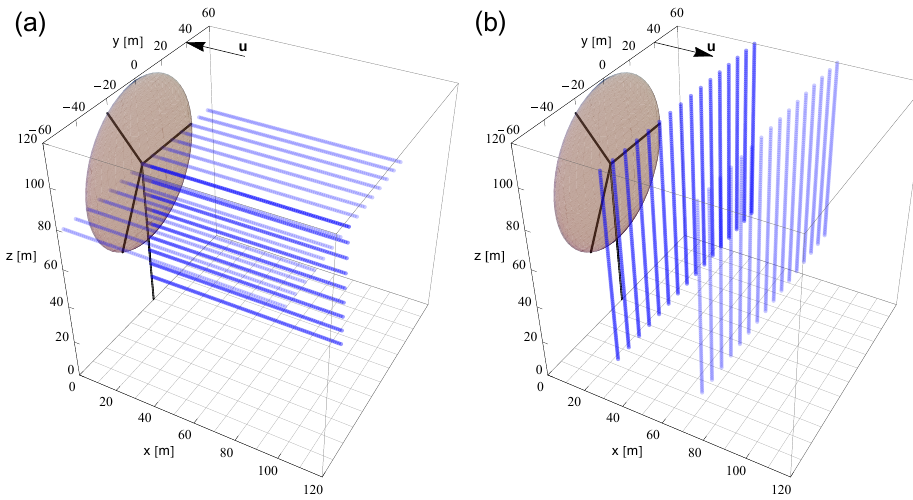
Figure 9. Scanning patterns of short-range WindScanners: (a) T-scan; (b) vertical planes.